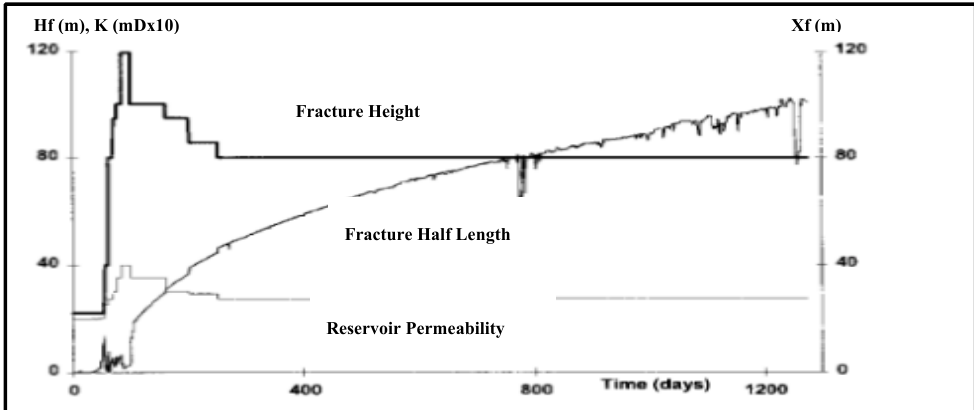
Figure 7. TIF dimensions and reservoir permeability in the final history match for well A [5].